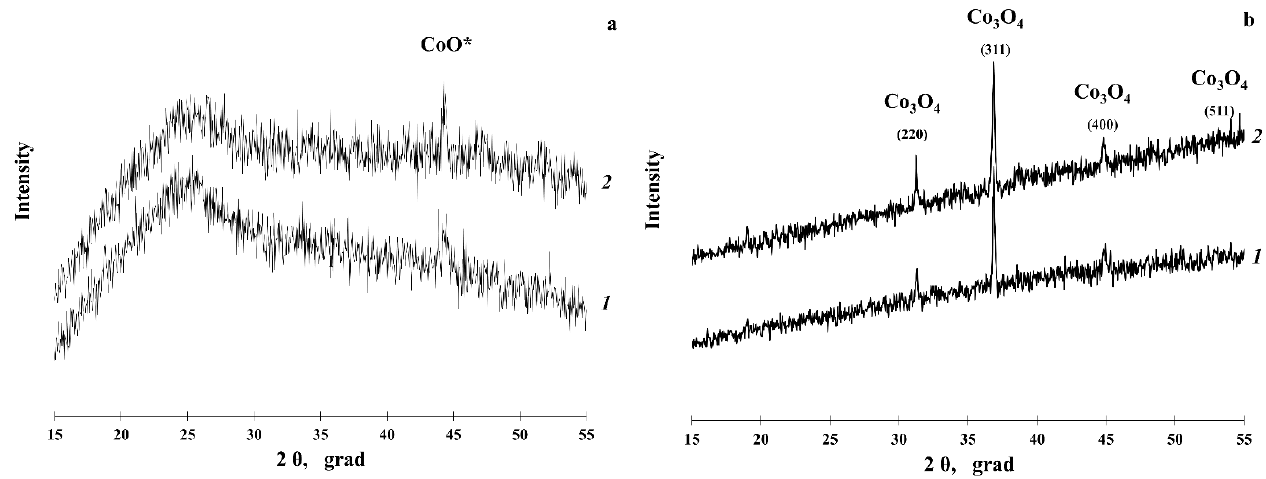
Figure 1. XRD patterns of materials: ( a ) 1—CoO/C—8% and 2—CoO/C—25%, ( b ) XRD patterns of materials 1—CoO/C— 8% and 2—CoO/C—25% after high temperature oxidation. * An approximate interpretation due to the presence of only one reflection of the CoO phase in the X-ray